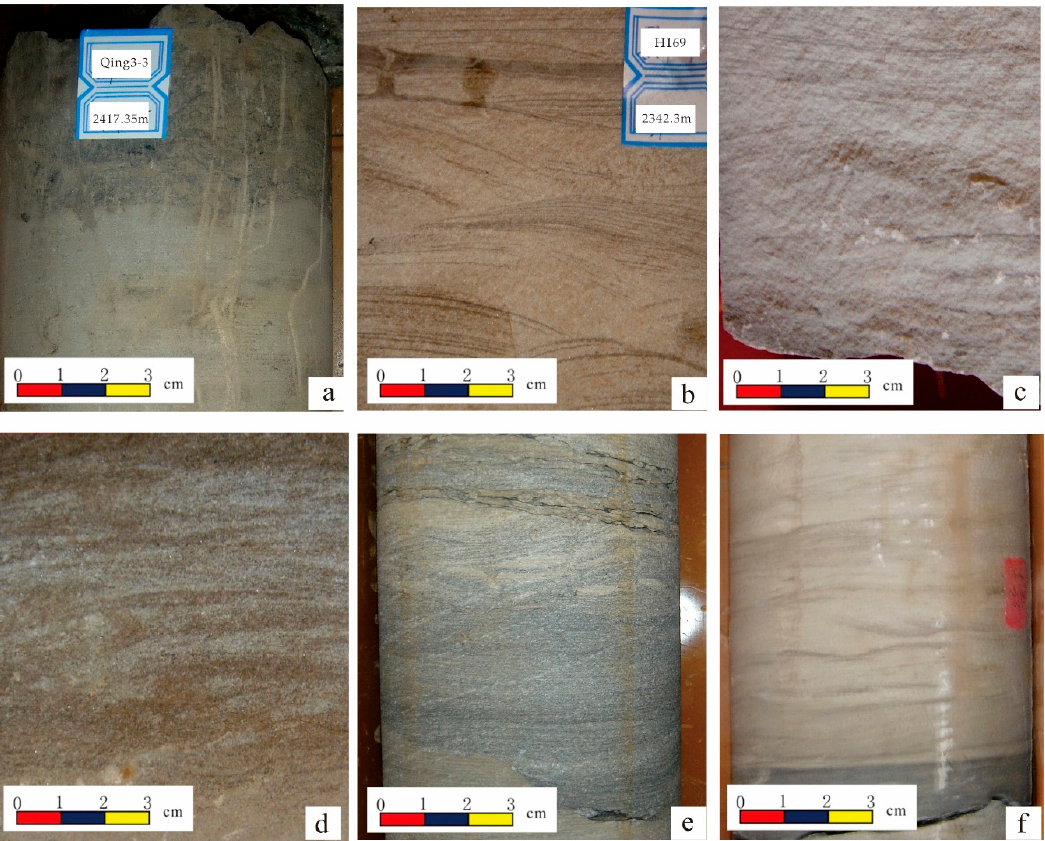
Figure 4. Photographs of cores of storm sediments. ( a ) Qing3-3, 2417.35m, scouring filling structure; ( b ) H169,2341.3m, hummocky cross bedding; ( c ) H169,2350.1m, hummocky cross bedding; ( d ) H169, 2342.5m, hummocky cross bedding; ( e ) H84, 2457.8m, slot mold structure; ( f ) H102, 2419.1m, wave ripple cross bedding.